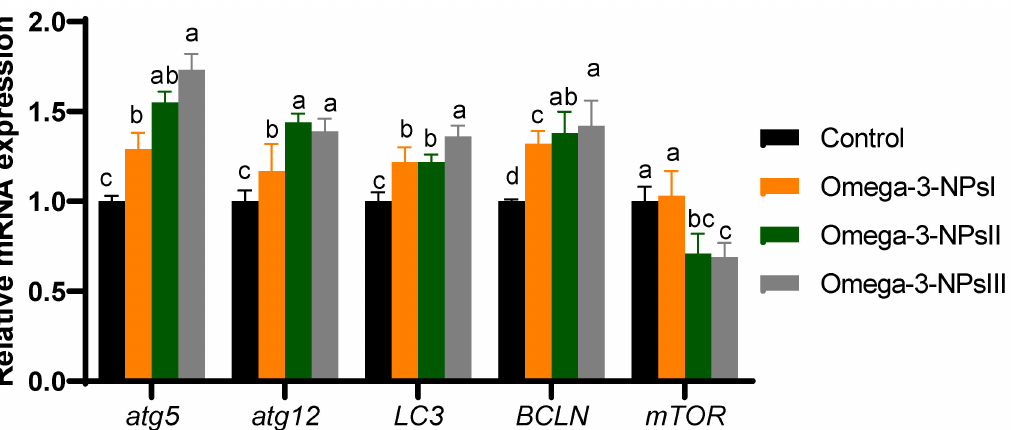
Figure 4. Effect of diets enriched with different supplemental levels of omega-3NPs (omega-3 nano particles) on real-time PCR analysis of autophagy-related genes [autophagy genes (atg5 and atg1microtubule-associated proteins 1A/1B light chain (LC3) and Beclin-1 (BCLN-1)), mechanistic target of rapamycin (mTOR)], and caspapase-1 in Nile tilapia post-challenge with Aeromonas hydrophila . Data are expressed as means ± SE. Bars with different letters denote significant differences ( p < 0.05). Control: basal diet without omega-3-NPs omega-3-NPsI, II, and III: basal diet supplemented with omega-3-NPs at levels of 1, 2, and 3 mg/kg diet,